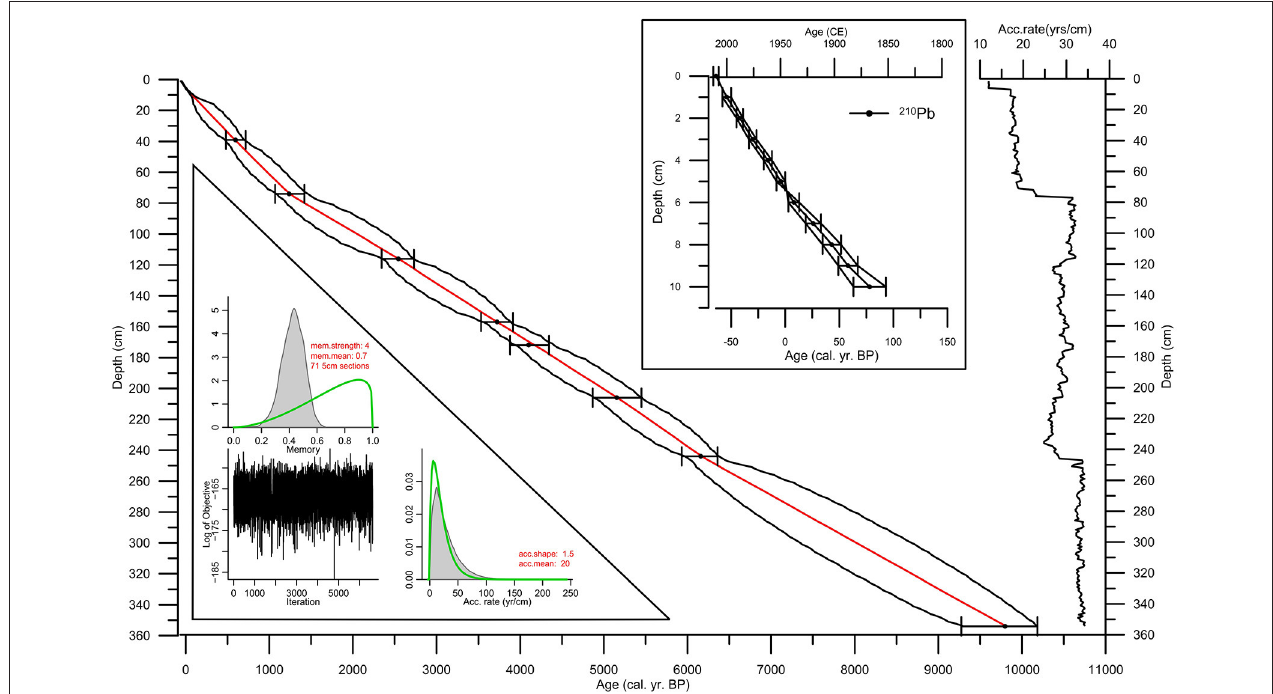
FIGURE 8 | The upper-most 210 Pb-dated sediments in VAP114 are shown in the upper inset figure. The age-depth model was constructed using the R-package Bacon v.2.2 ( Blaauw and Christen, 2011) and includes the 210 Pb-dated sediments in the top of the core (inlet figure) and the radiocarbon dates from Table 2 . The error bars indicate the 2 σ uncertainty range for each radiocarbon sample. The reconstructed sedimentation rate (years/cm) is shown on the right-hand side. Also, the output panels from the age-depth modeling using the Bacon v.2.2 is found in the lower left inset